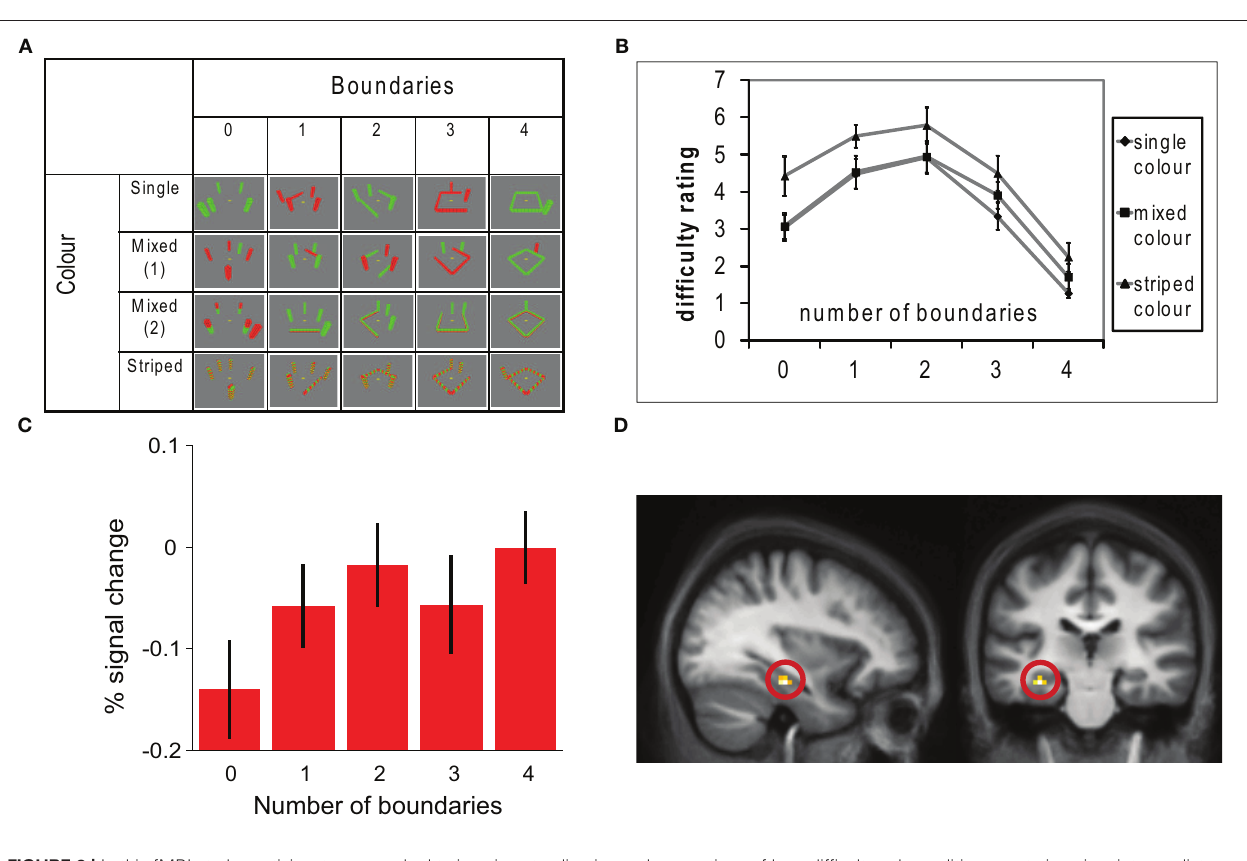
shows ratings of how difficult each condition was to imagine; intermediate numbers of boundaries and the striped colored conditions were rated most difficult. Panel (C) shows a parametric modulation of activity in a region of the left hippocampus with increasing numbers of boundaries in the imagined scenes. This region is shown in (D) . These results are consistent with the hippocampus representing location within an imagined environment with respect to extended environmental